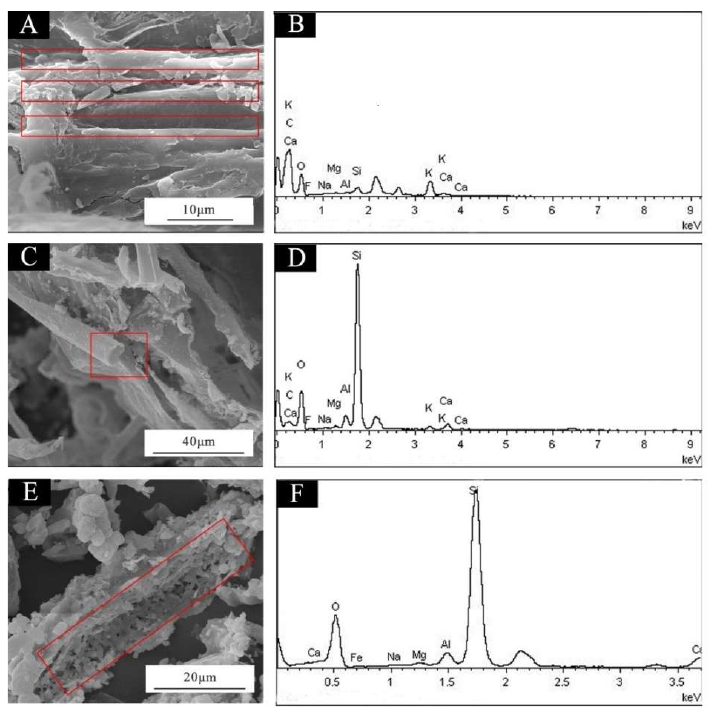
Figure 1. SEM images of ( A ) wheat straw powder, ( C ) WSPALR, and ( E ) high-temperature calcined WSPALR. EDX analysis of ( B ) wheat straw powder, ( D ) WSPALR, and ( F ) high-temperature calcined WSPALR.